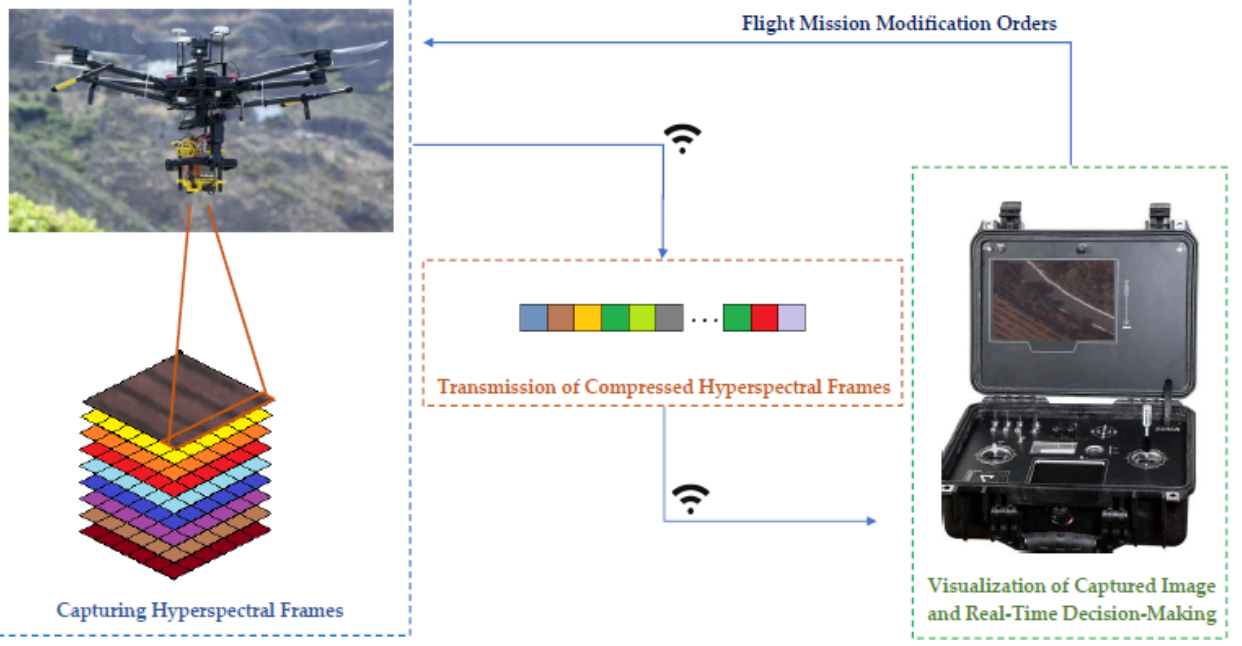
Figure 1. Overall description of the targeted design